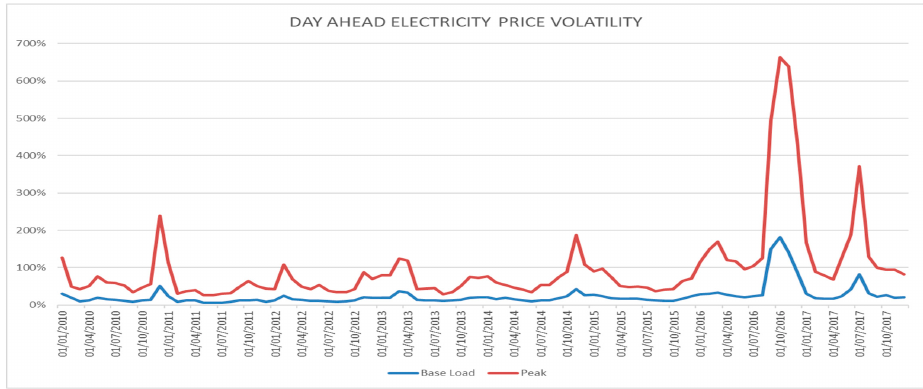
Figure 2. Volatility of Day Ahead Electricity Prices. Source: Department of Energy and Climate Change [103].